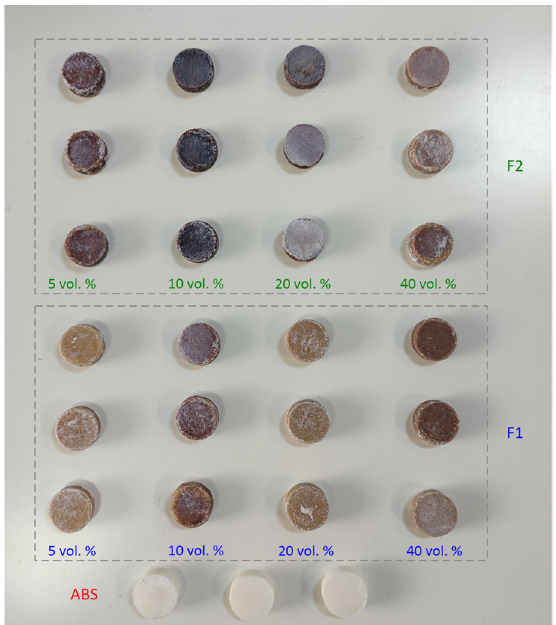
Figure 3. Samples produced by compression molding from neat ABS and F1 and F2 fillers in different proportions.